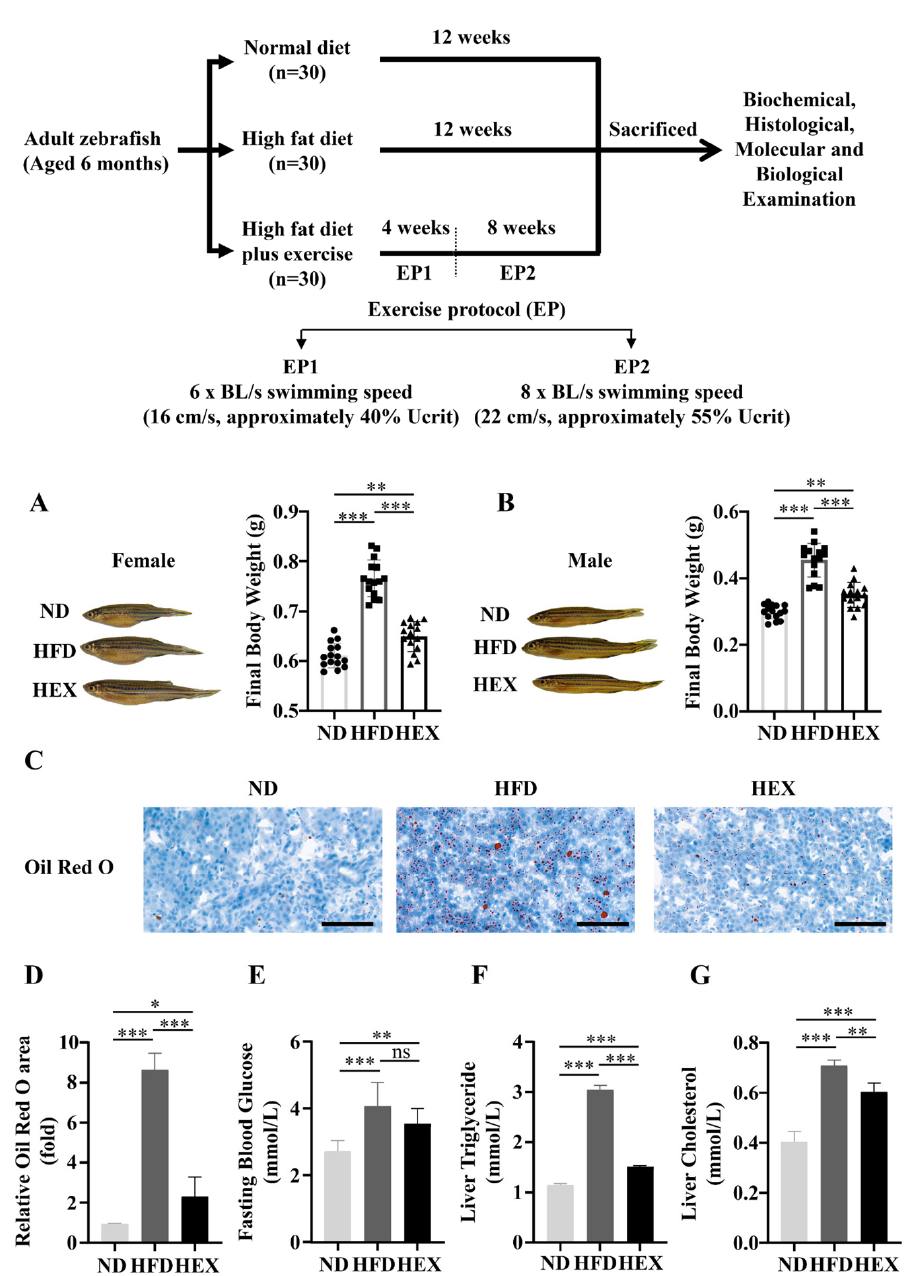
Figure 1. Zebrafish receiving a high exercise regimen (HEX) had reduced body weight gain and lipid accumulation compared to high-fat diet (HFD) zebrafish. Normal diet (ND) zebrafish represent the control group. ( A , B ) Morphology and body weight of zebrafish. ( C ) Oil Red O staining of zebrafish livers ( n = 3). ( D ) Quantitation of Oil Red O staining. ( E ) Fasting blood glucose (ND, n = 13; HFD, n = 10; HEX, n = 11). ( F ) Liver triglyceride ( n = 5). ( G ) Liver cholesterol ( n = 5). The above experiments were carried out using 9-month-old zebrafish. *, p < 0.05, **, p < 0.01, ***, p < 0.001. Data represent the mean, and error bars represent SEM. Scale bar, 20 µ m. NAFLD, non-alcoholic fatty liver disease; ND, normal diet; HFD, high fat diet; HEX, high-fat diet plus exercise.